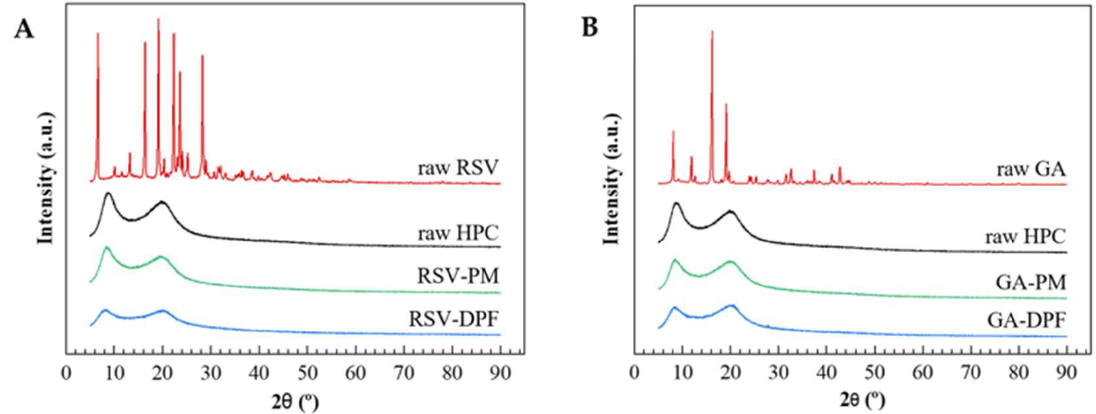
Figure 5. XRD diffractograms of ( A ) RSV–DPF and ( B ) GA–DPF; PM: physical mixture.